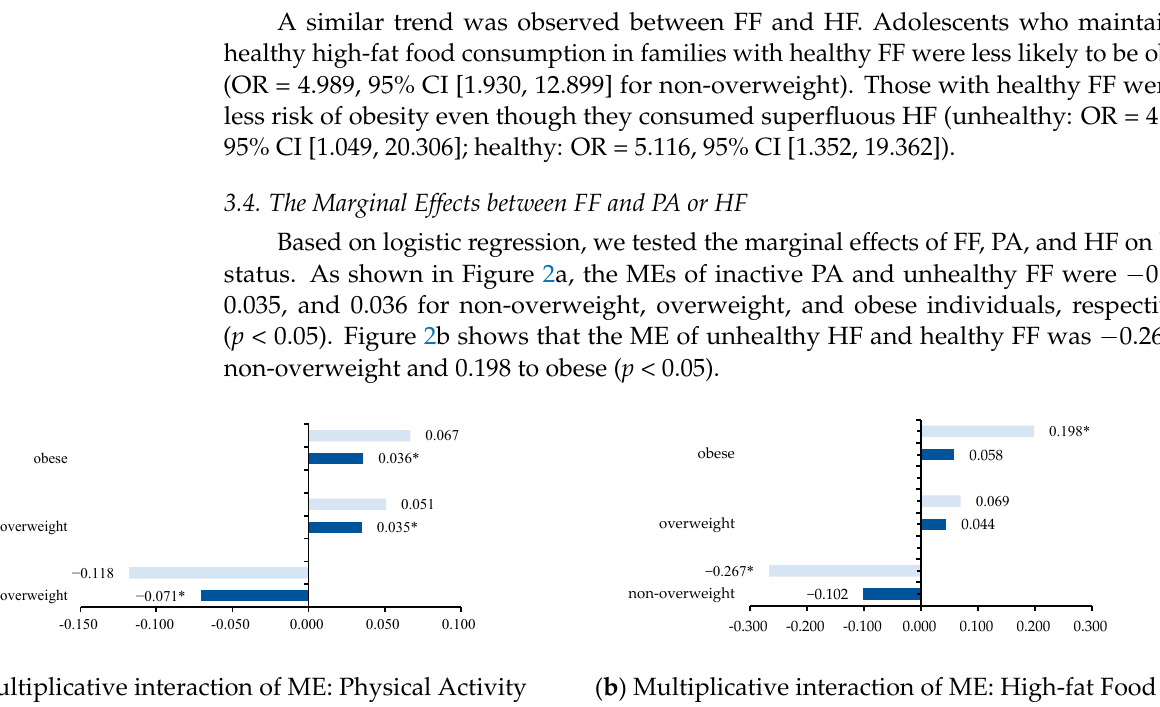
Figure 2. ( a ) Shows the marginal effect of PA at a specific value (PA = 1, which means inactive PA); the darker bars represent the marginal effect of inactive PA and unhealthy FF on BMI status, including non-overweight, overweight, and obese; the lighter bars represent the effect of inactive PA and healthy FF on BMI status; ( b ) shows the marginal effect of HF at a specific value (HF = 1, which means unhealthy intake of HF); the darker bars represent the marginal effect of unhealthy HF and unhealthy FF on BMI status; the lighter bars represent the effect of unhealthy HF and healthy FF on BMI status. * p < 0.05.